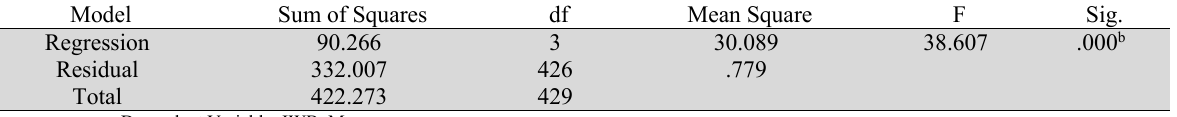
The results of ANNOVA test